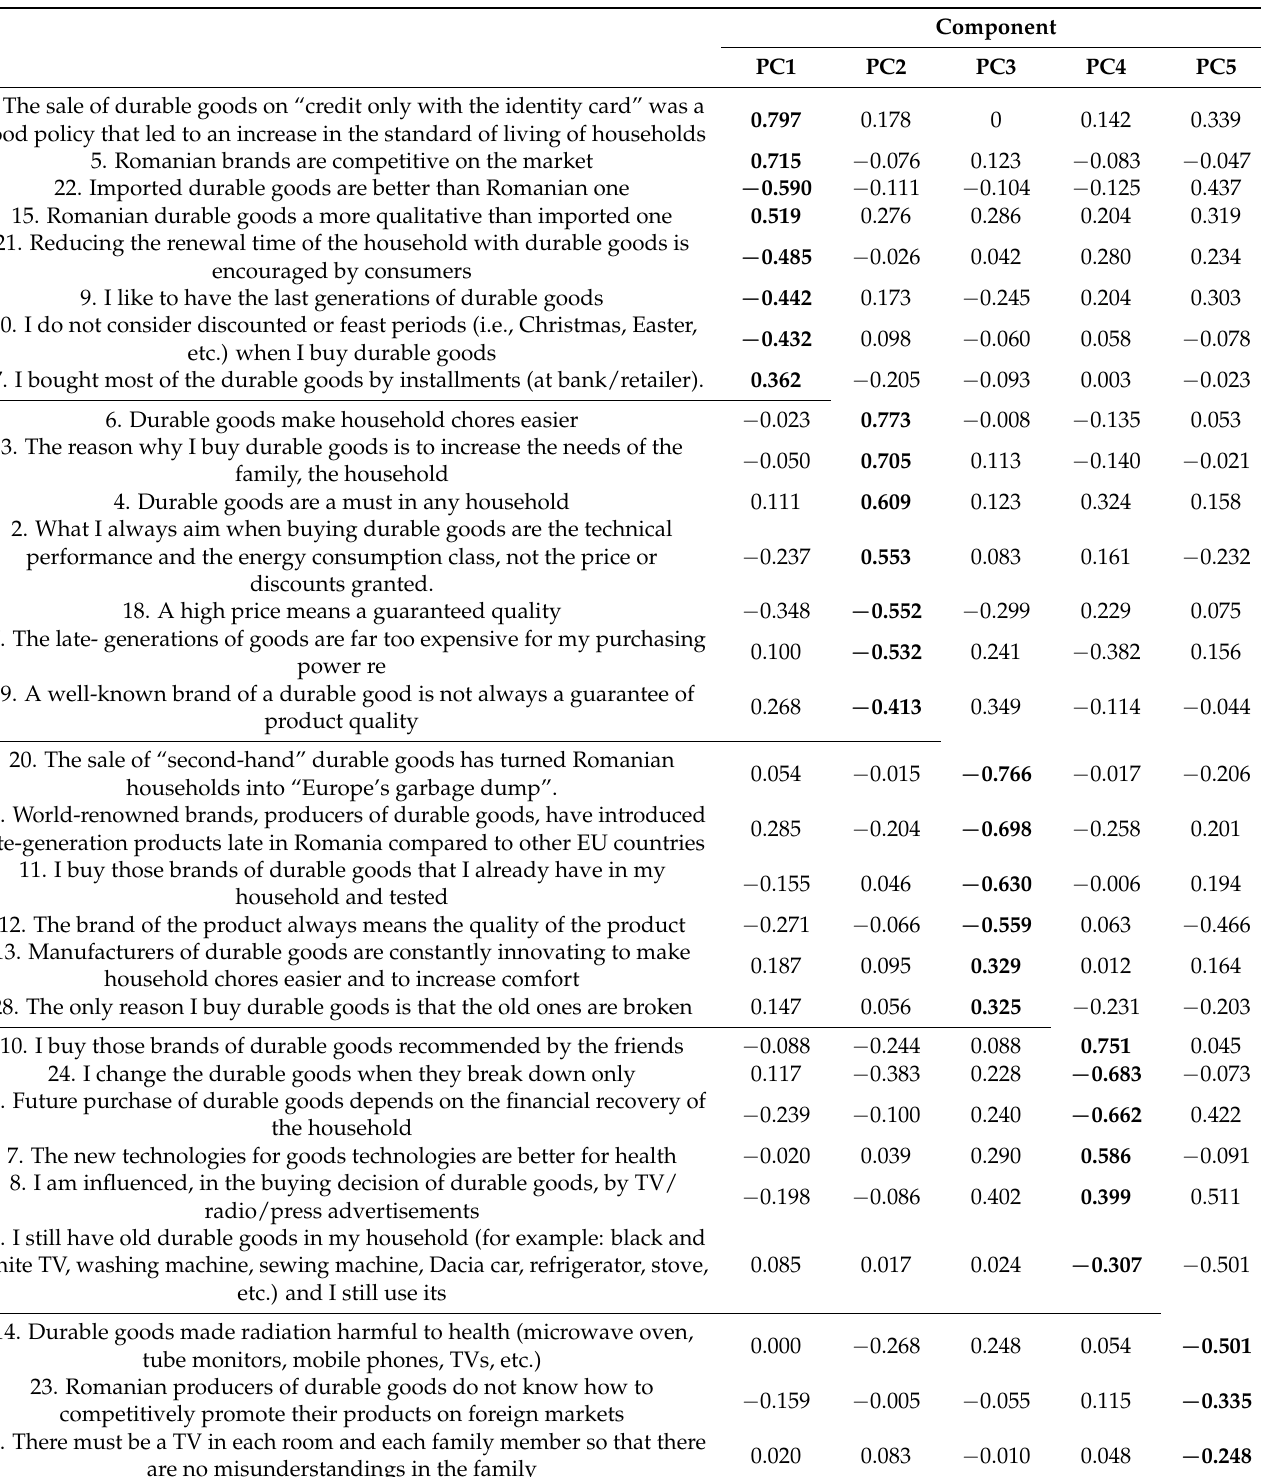
Table 5. Rotated component matrix